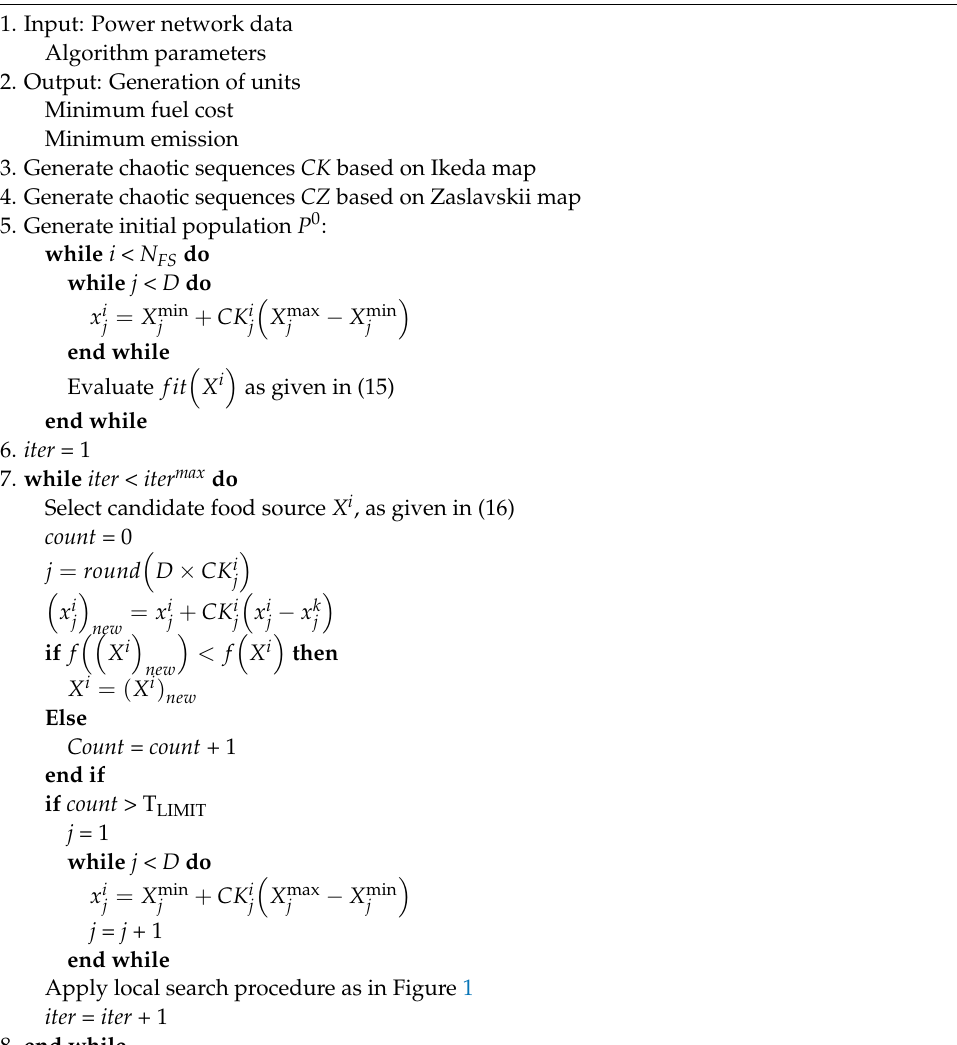
Algorithm 1. Pseudo-code of the